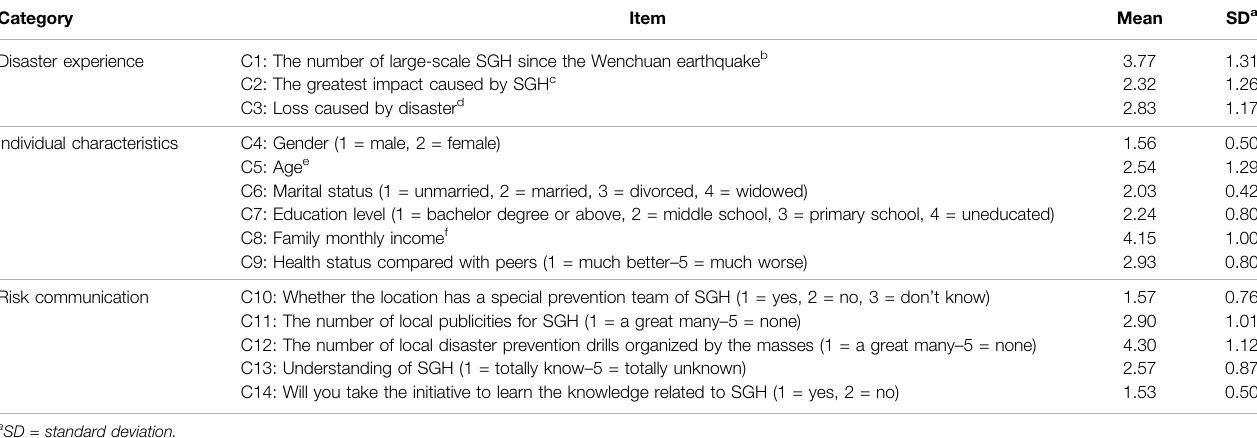
TABLE 2 | In fl uences on rural residents ’ disaster risk perception.